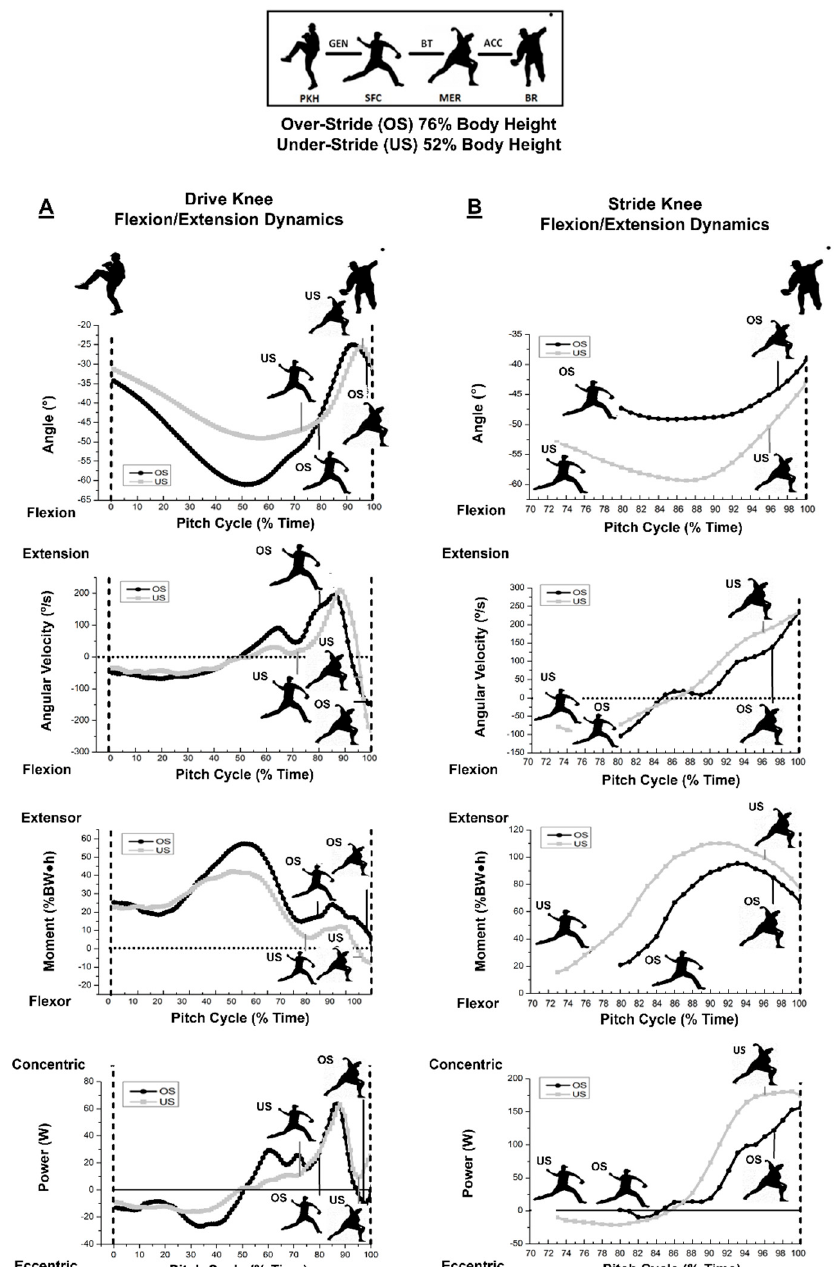
Figure 1. ( A ) Drive knee flexion/extension dynamics. Flexion ( − )/extension (+) drive knee dynamics. OS indicated greater knee flexion during the generation phase, with greater knee extension and moments during brace-transfer as well as increased knee extension moments at maximal external rotation. US presented greater knee flexion angular velocities during the generation and acceleration phases, knee flexion moments at maximal external rotation, and concentric knee flexion power during the acceleration phase. OS indicated small eccentric knee extension power during the acceleration phase, slowing the rate of knee flexion. ( B ) Stride knee flexion/extension dynamics. Knee kinematic conventions describing closed kinetic chain (CKC) movement following SFC (73% and 80% time for under- and over-stride pitching). Stride knee flexion ( − )/extension (+) dynamics; OS indicated greater knee extension from SFC to BR. No significant differences were reported in angular velocities. US indicated greater knee extensor moments at MER and ACC with greater power generation during ACC.